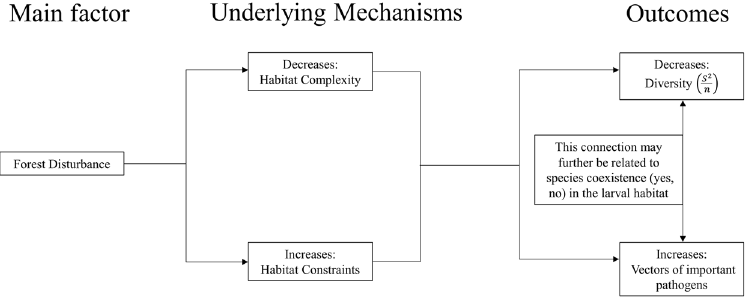
Figure 3. Theoretical synthesis of the results obtained in the present work. The main factor, forest disturbance, decreases habitat complexity and increases habitat constraints. These underlying mechanisms decrease diversity and increase vectors of important